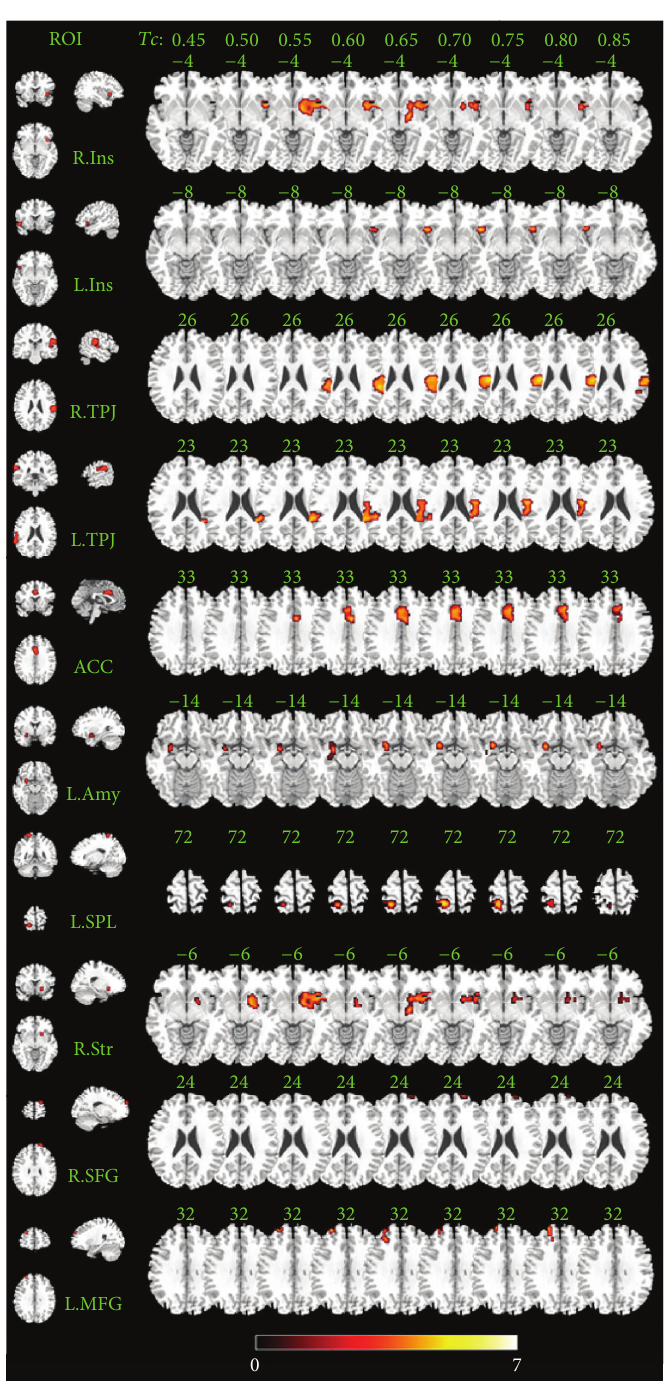
Figure 3: Significantly increased local FCD in musicians compared with nonmusicians. The left column shows 10 ROIs’ position. The right part shows significantly increased local FCD in 10 axis images and 9Tc values separately. ROIs’ abbreviations are consistent with those shown in Table